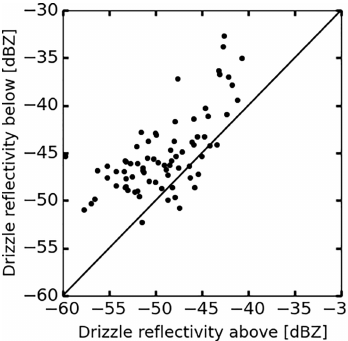
Figure 13. Comparison with the drizzle liquid water path below the cloud base as retrieved using the technique of O’Connor et al. (2005), available as one of the Cloudnet products. The diagonal line marks the one-to-one